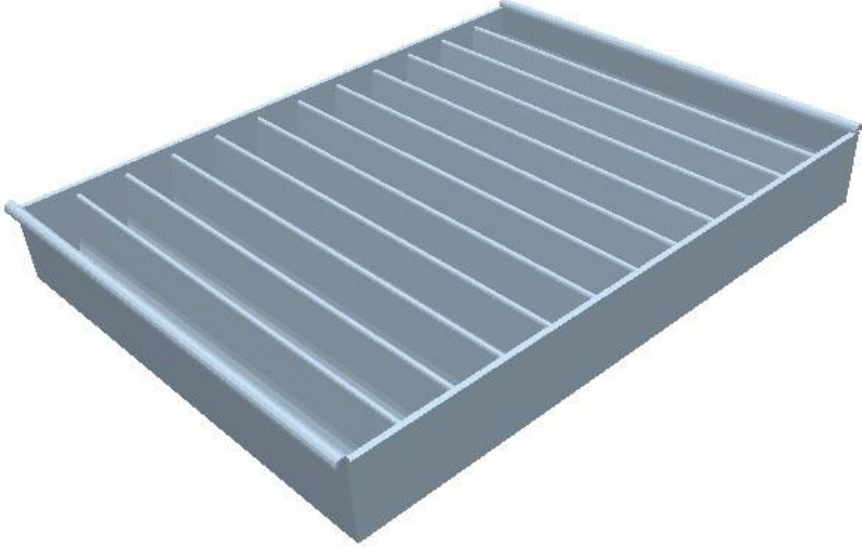
Figure 6. Simulation model imported into EDEM.